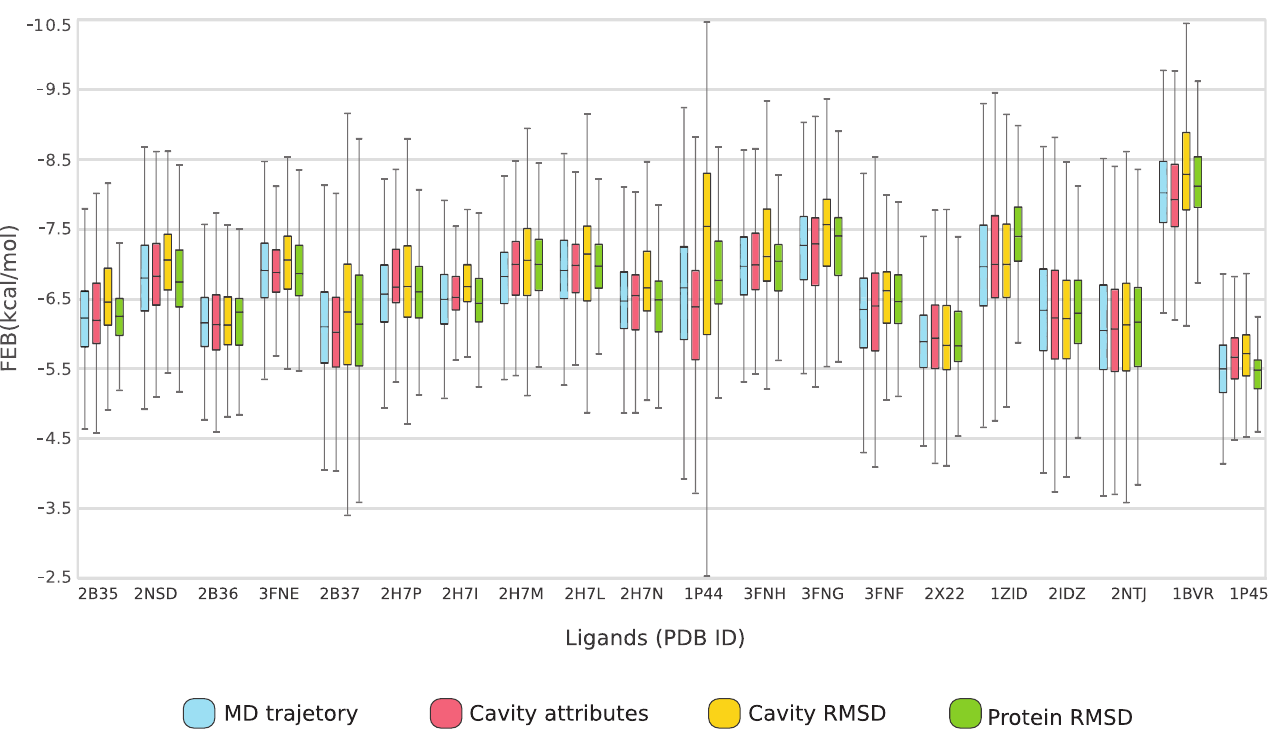
Fig 6. The ensemble of representative MD conformations generated from the best partitioning solution. The boxplot represents the trends in docking result changes in median FEB per data set and per ligand. The data sets are represented by different colors, where, pink, yellow, and green are the data sets used in the clustering experiments and blue is the original